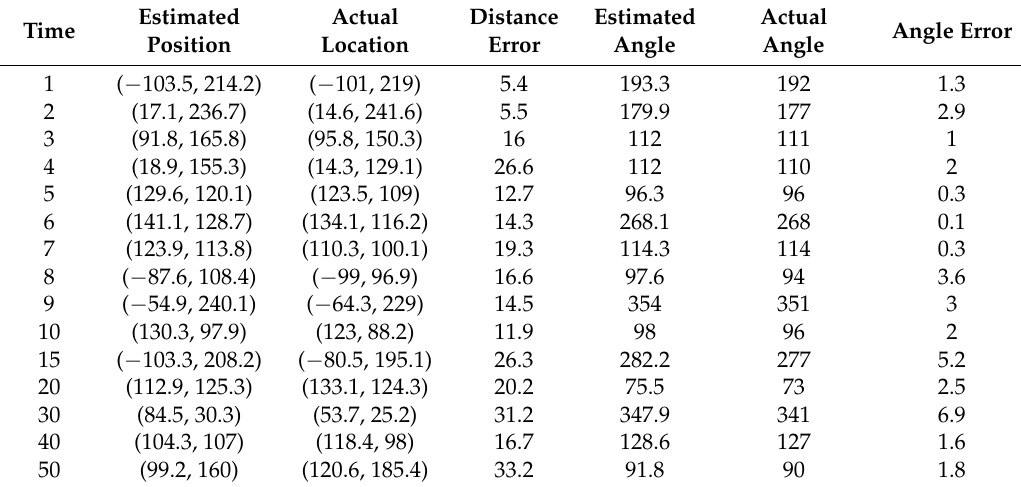
Table 12. Comparison of adding ultrasonic sensor (200